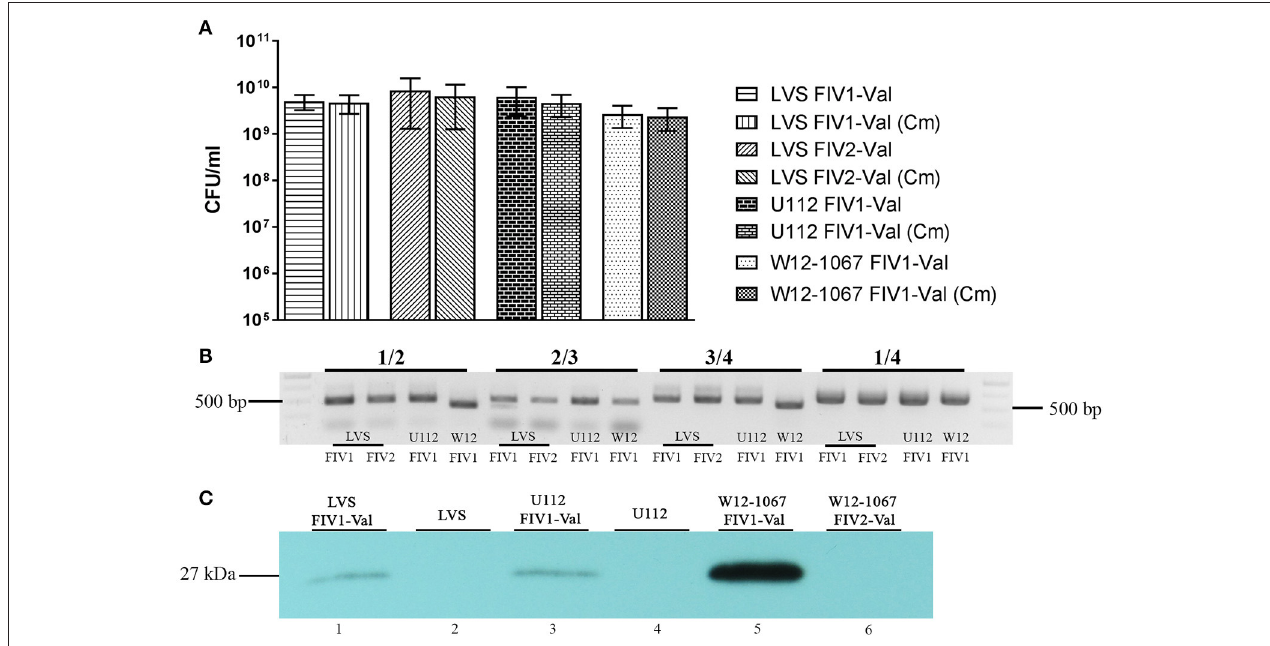
FIGURE 3 | Stability of FhaGI-1-based vectors. Strains Fth LVS FIV1-Val, Fth LVS FIV2-Val, Fno U112 FIV1-Val, and Francisella sp. W12-1067 FIV1-Val were passaged 10 times in mediumT without antibiotics. (A) CFU of strains on HCA agar and HCA agar containing Chloramphenicol (10 µ g ml − 1 ) after 10 passages in mediumT without antibiotics; results shown are means with SD of three independent experiments. (B) PCR analysis of genomic DNA of strains after 10 passages without antibiotics. Primers 2/3 (Fha-2**/Fha-3*) show the presence of the episomal form, primers 1/2 and 3/4 (Fha-1 or Fha-1 W12 /Fha-2** and Fha-3*/Fha-4* or Fha-4 W12 ) show the chromosomally integrated form of FIV-Val, and primers 1/4 (Fha-1/Fha-4* or Fha-1 W12 /Fha-4 W12 ) show the chromosomal attB- site. (C) Western Blot analysis of whole cell lysates with rabbit- α -gfp antibody